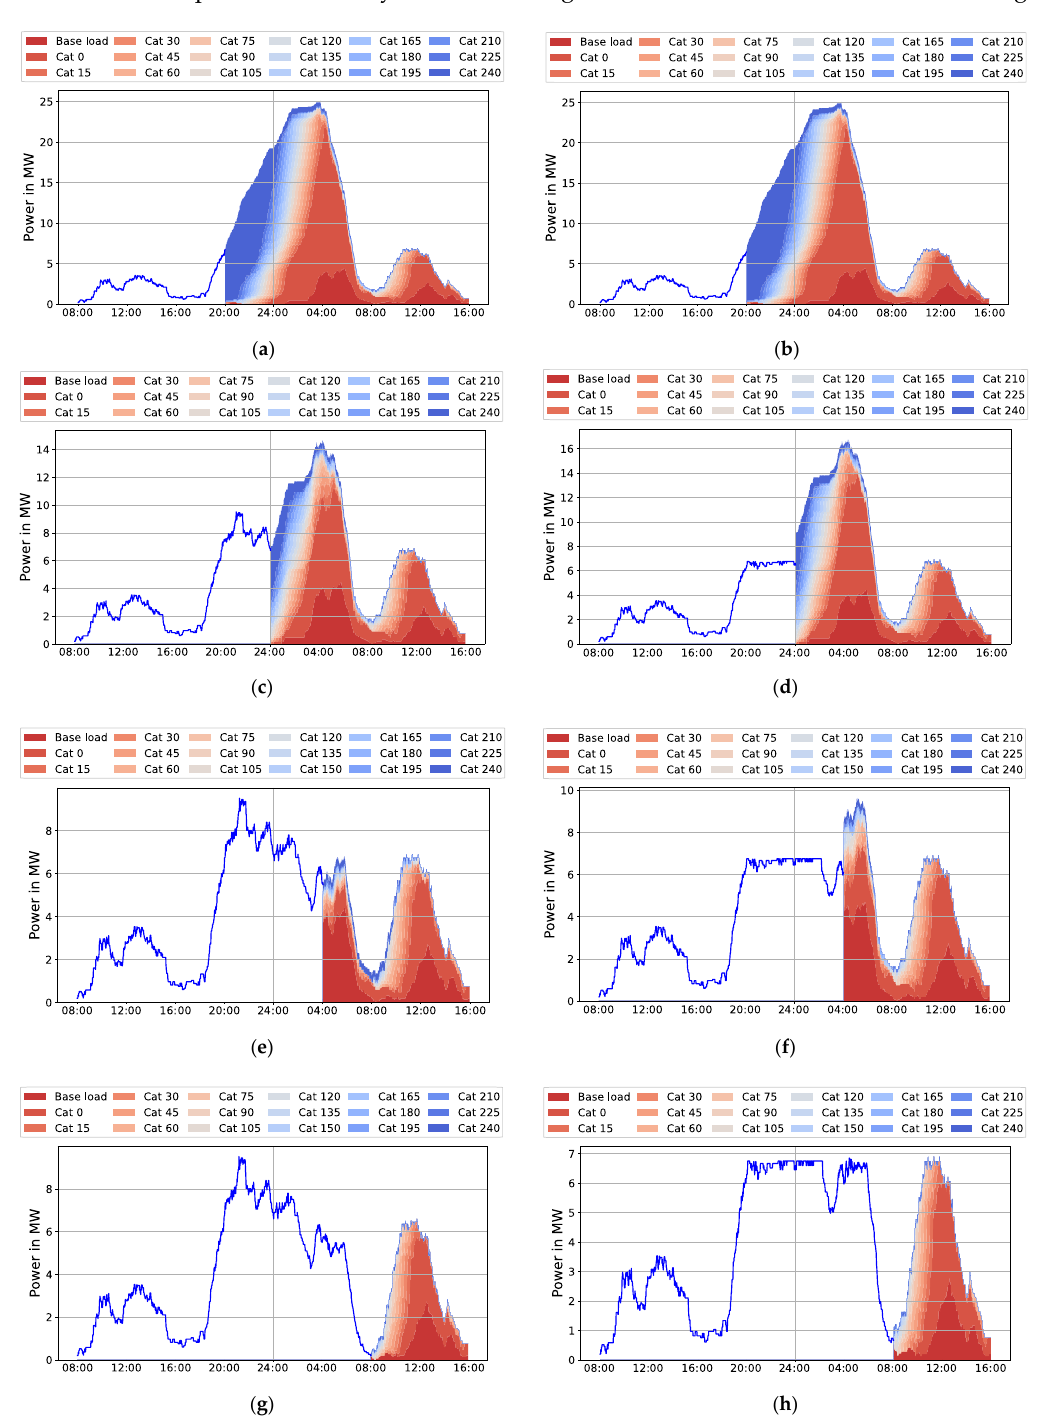
Figure 9. Calculated flexibility for BD1 from the perspective of 20:00 h and 24:00 h as well as 04:00 h and 08:00 h on the following day. The diagrams on the left side ( a , c , e , g ) represent the uncontrolled charging and the diagrams on the right side ( b , d , f , h ) represent controlled charging.